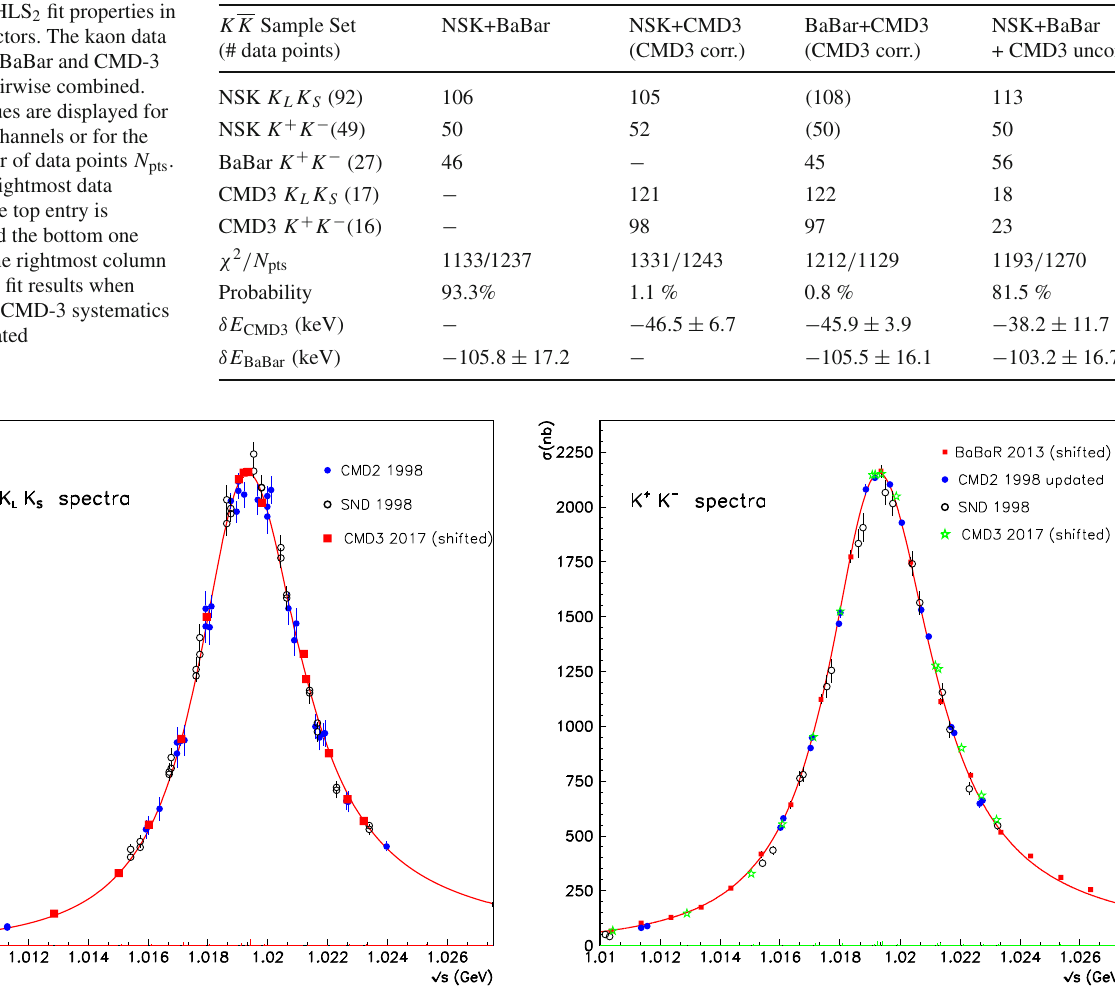
Fig. 5 BHLS 2 global fit to the K + K − and K L K S spectra (RS solution): the plotted CMD-3 data are not fitted but are shifted by a δ E CMD3 determined elsewhere. The value for δ E BaBar has been derived from this fit. All experimental spectra are rescaled as emphasized in the